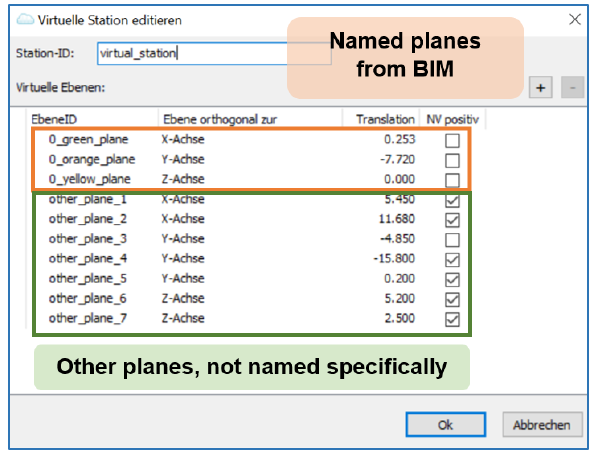
Figure 6. Graphical user interface for selecting the BIM faces in the registration software. If necessary, for example with layered walls, the translation can be adjusted or the orientation of the normal vector can be changed. The entire BIM is named as virtual station for demonstration